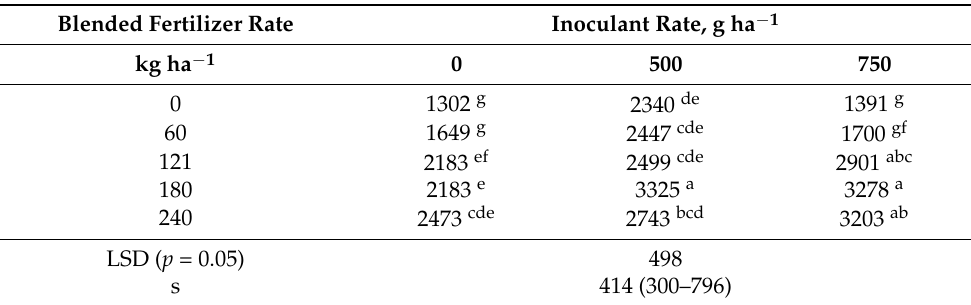
Figure 4. Relationship between the number of active nodules per plant and seed yield. Table 10. The seed yields of faba bean receiving combed application of blended fertilizer and the inoculant.